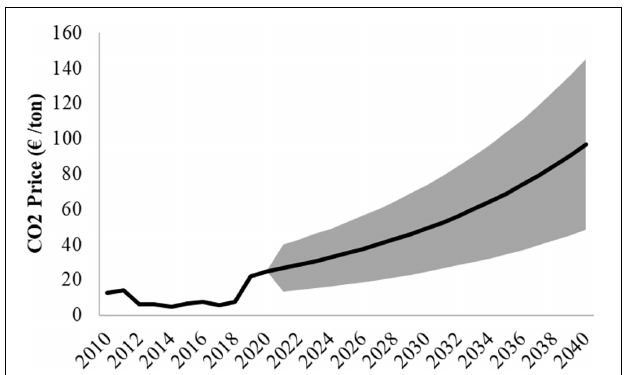
FIGURE 2 | Projected Prices of CO 2